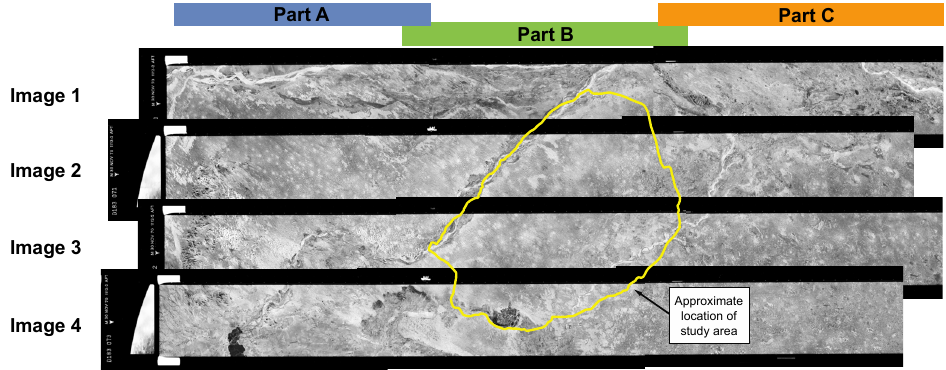
Figure 3. Location of the study area with respect to the original Corona image strips.